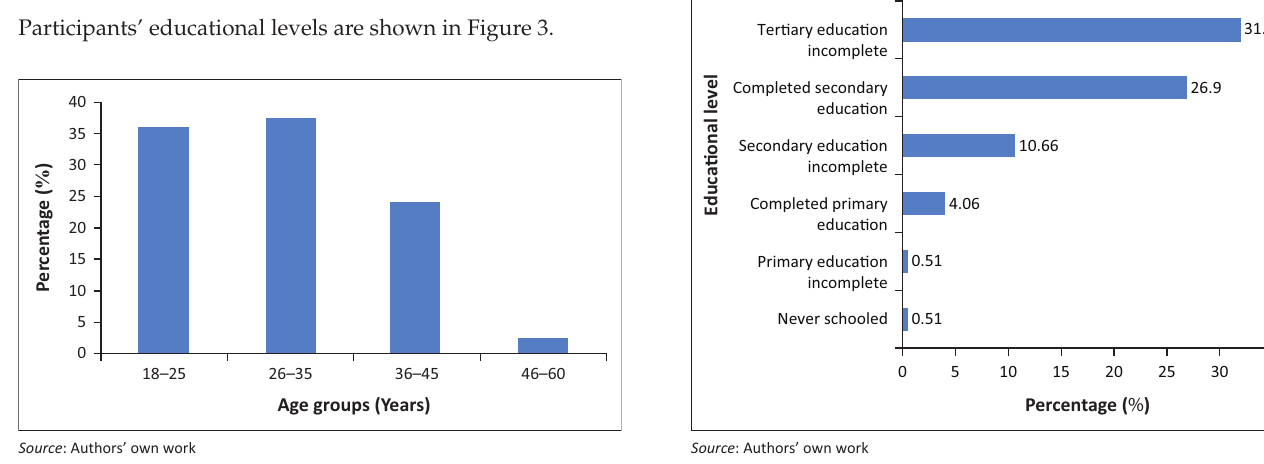
FIGURE 3: Participants’ educational